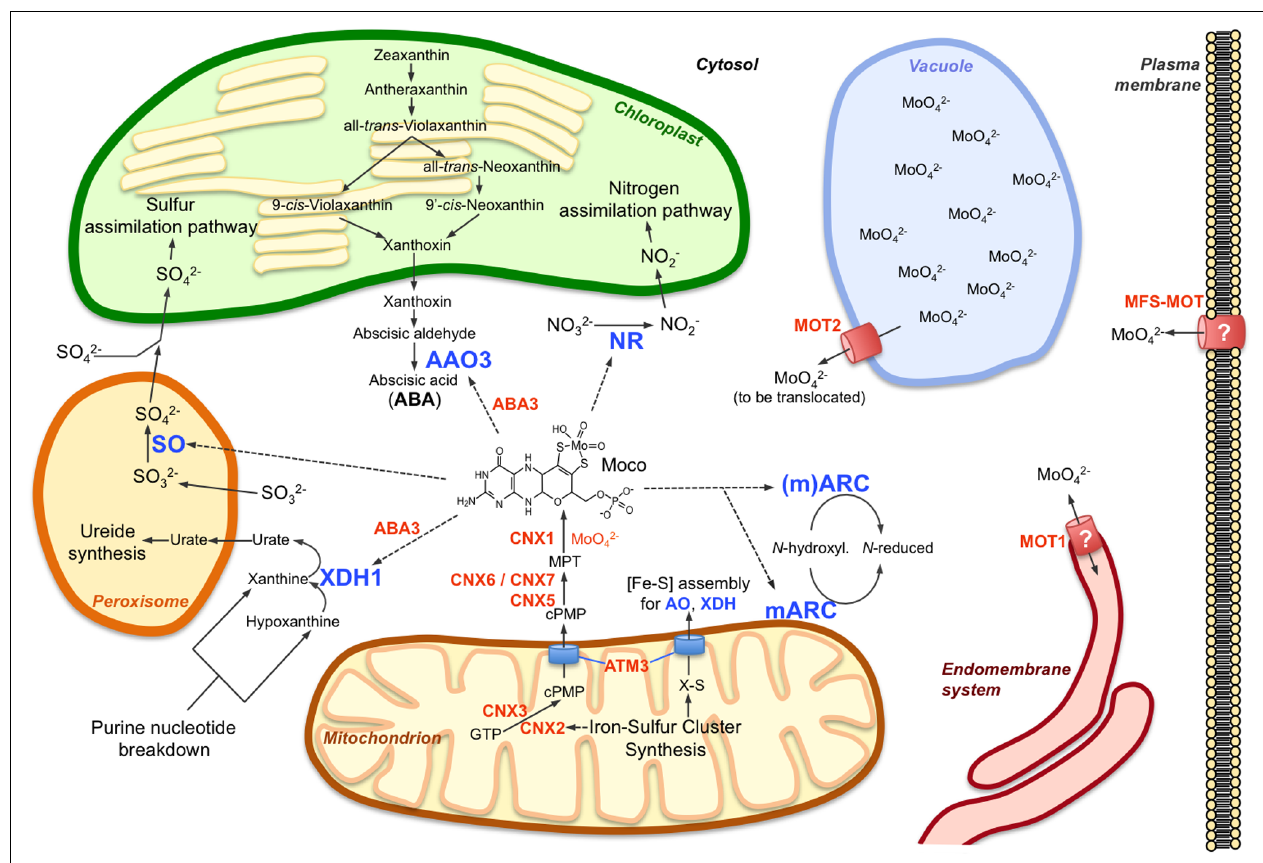
mitochondrial localization of MOT1 has also been reported but appears less likely as no obvious reason exists for import or export of molybdate into or out of the mitochondria, respectively.The plant homolog (MFS-MOT) of the major facilitator superfamily molybdate transporter MOT2 from Chlamydomonas might be required for molybdate import across the plasma membrane.The function of the Moco sulfurase ABA3 in activation of AO and XDH is indicated, just as the functions of the mitochondrial ABC transporter ATM3 in export of cPMP from mitochondria and in cytosolic iron-sulfur cluster ([Fe-S]) assembly for AO and XDH (and other extra-mitochondrial proteins). Further details are given in the main text and are reviewed by Bittner and Mendel (2010) and Mendel (2013). Molybdo-enzymes are indicated by blue letters, other components of molybdenum metabolism by orange letters; dotted arrows indicate requirement for Moco by